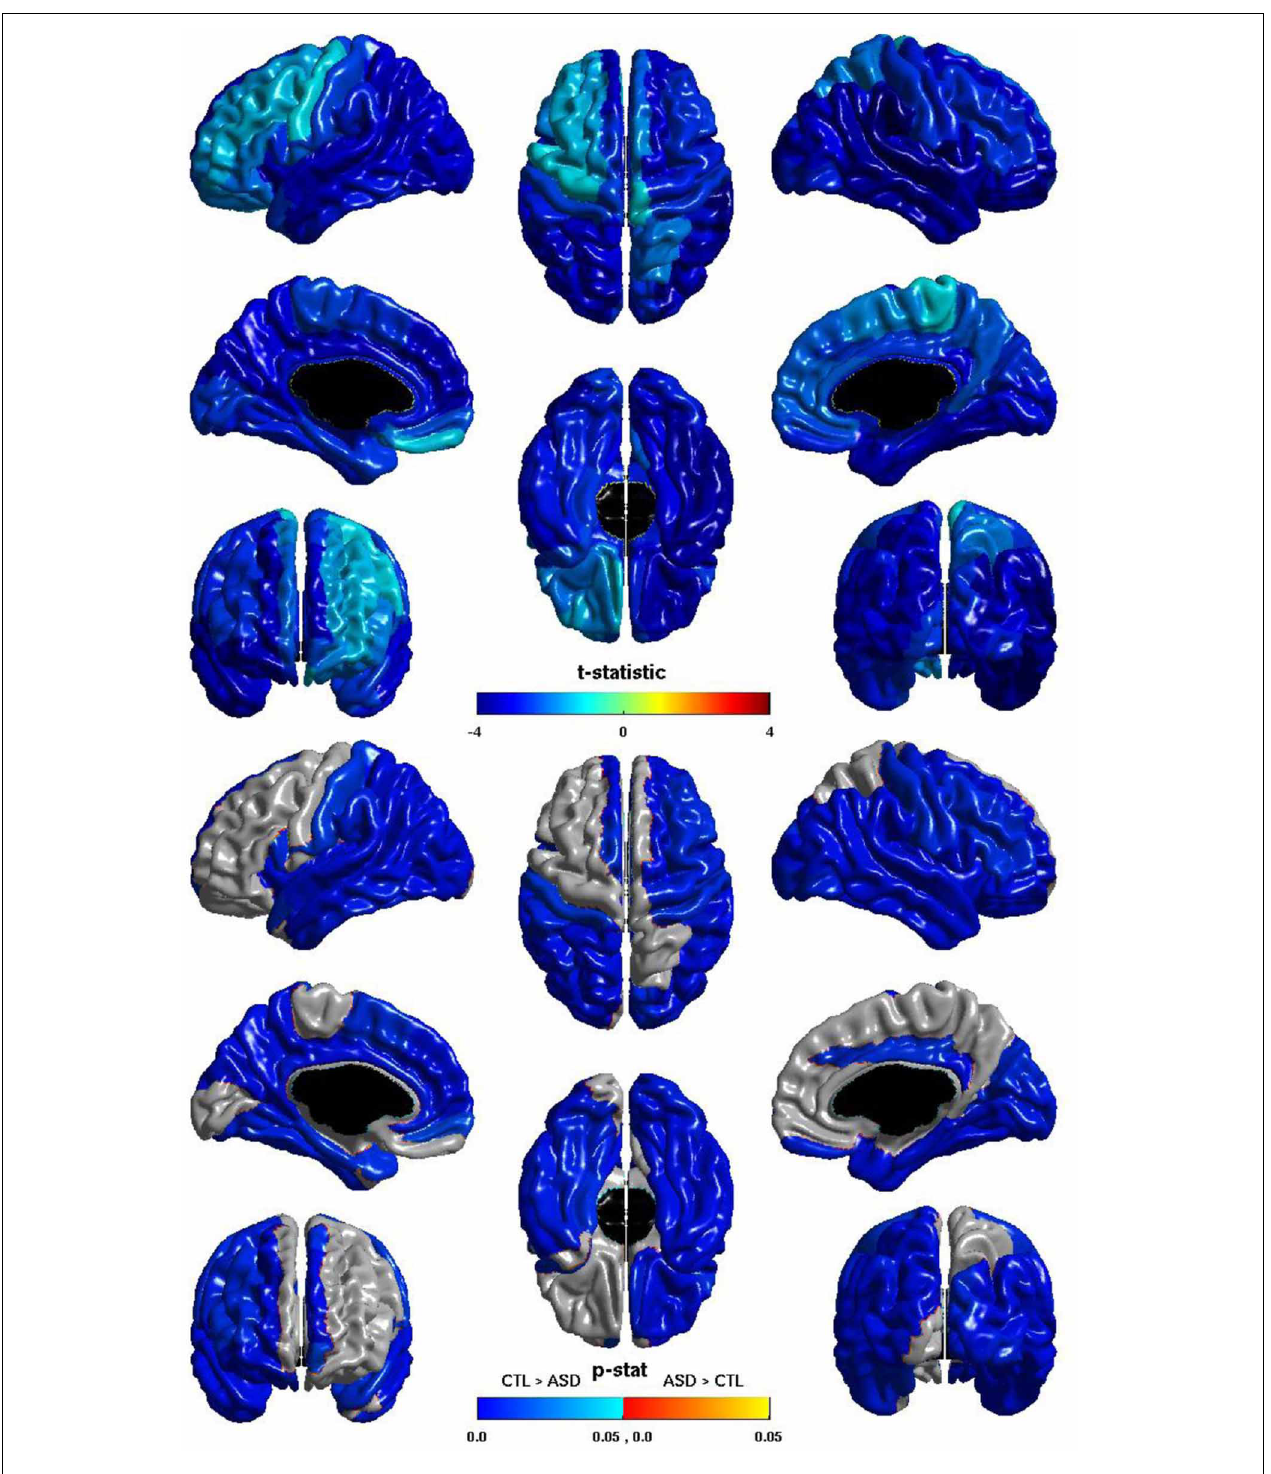
FIGURE 3 | Nodal Local Efficiency and Group. The t -statistic (top) and the p -statistic (bottom) for the group difference in nodal local efficiency in each region of the AAL atlas. A negative t -statistic represents reduced efficiency in ASD. The t -statistic is negative everywhere. The p -statistic is FDR-corrected, and is blue where there is a significant reduction in nodal local efficiency in ASD, and orange where there is a significant increase in ASD. No regions